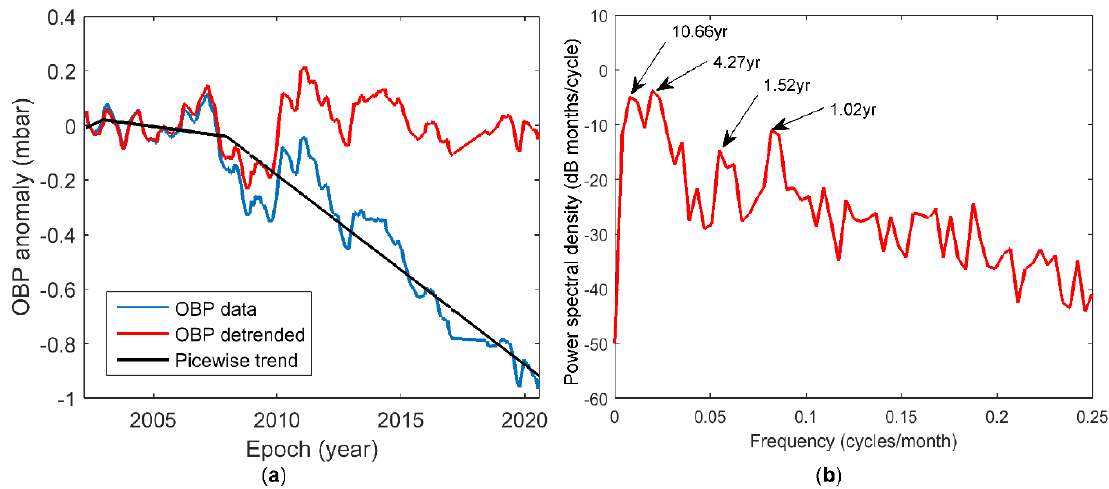
Figure 5. ( a ) OBP time series (blue line), piecewise trend (black line), and detrended OBP time series (red line). ( b ) Power spectrum density of the detrended OBP time series.